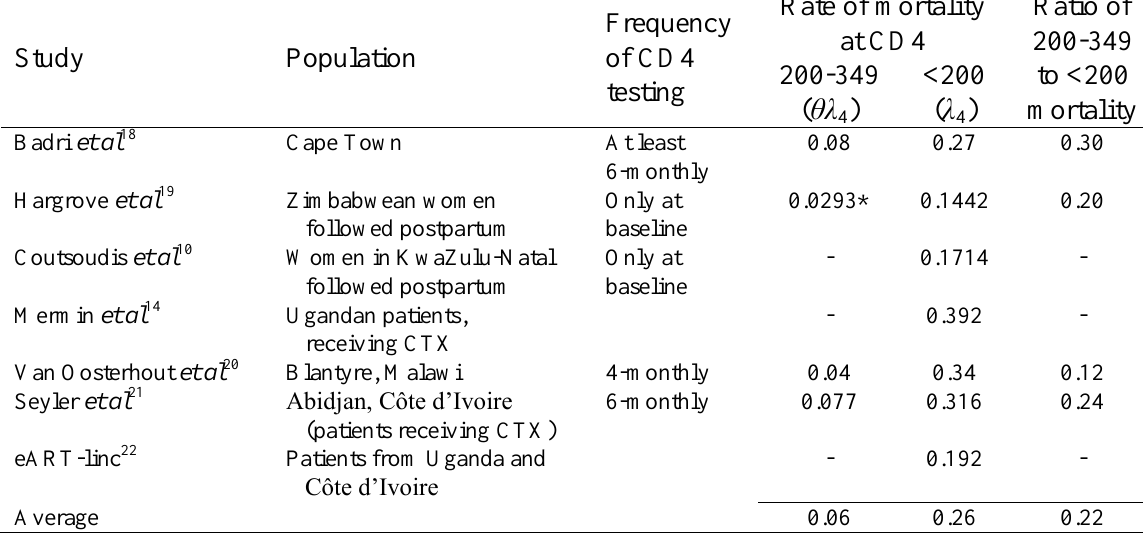
Rate of mortality at CD4